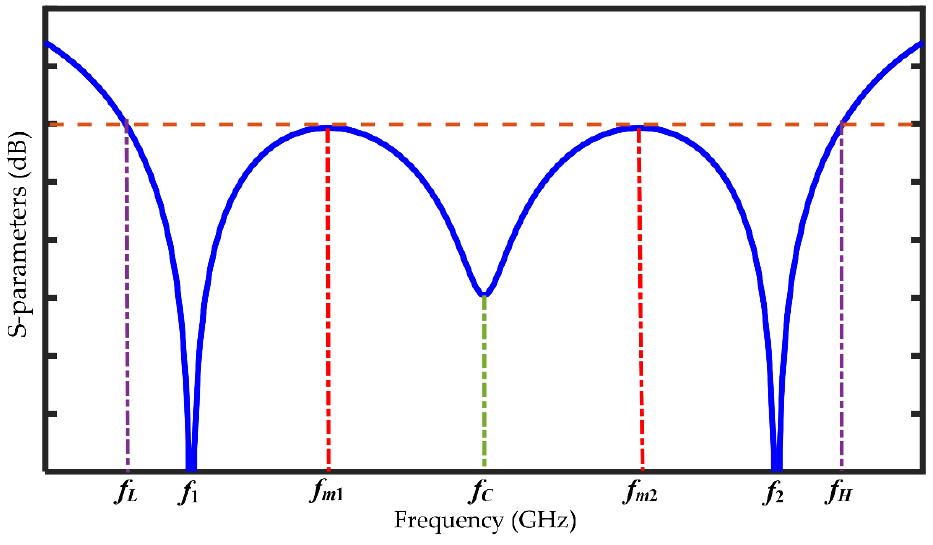
Figure 4. Specific frequency terms in S-Parameters.